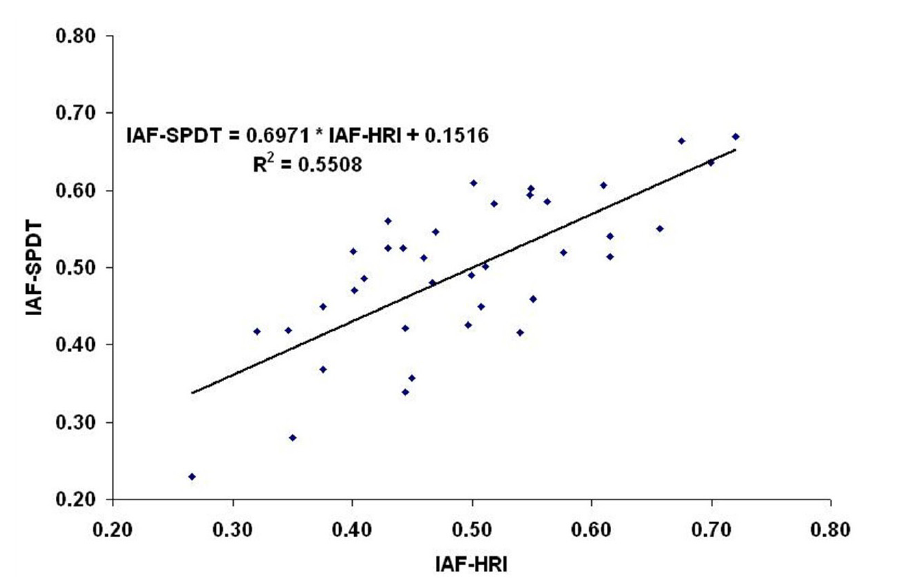
Figure 6. Irrigated area fractions (IAFs) from 2 methods. The relationship between the IAF-HRI versus IAF-SPDT. Table 1. Irrigated area fractions (IAFs) using 3 methods. The IAF from: (a) Google Earth Estimates (IAF- GEE), high resolution imagery (HRI), and (c) SPDT for the 28 global irrigated area mapping